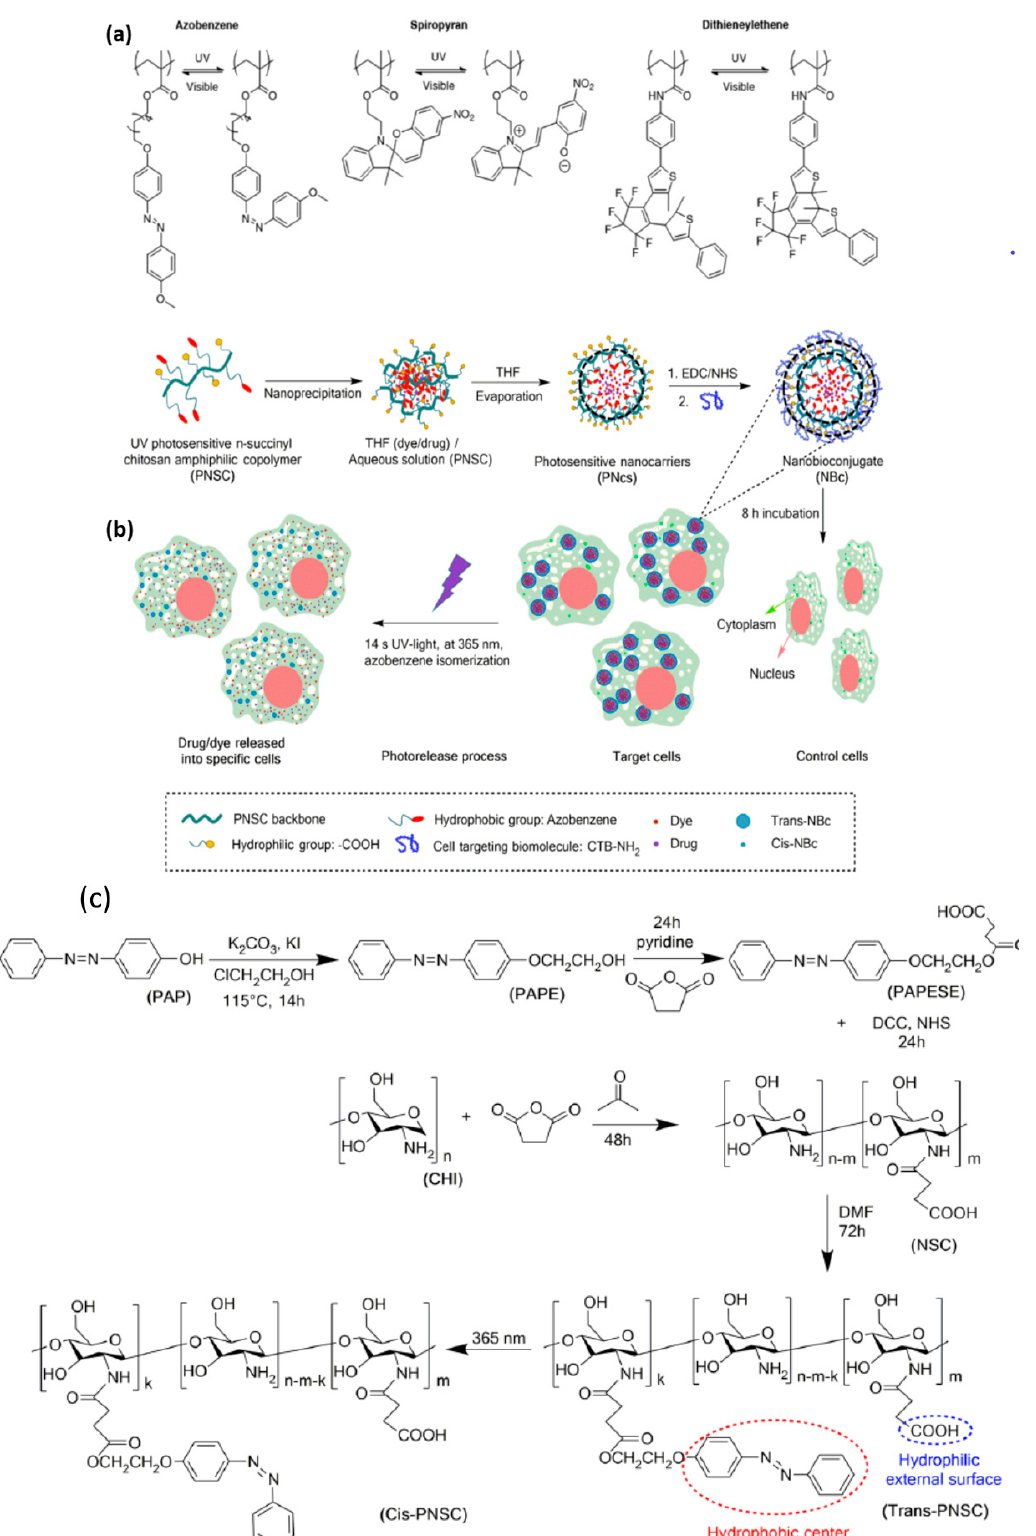
Figure 4. ( a ) Examples of photoisomerizable groups for reversible light ‐ responsive nanomaterials. Reproduced from [65], with permission from © The Royal Society of Chemistry 2017. ( b ) Synthesis of PNc and UV light drug release. ( c ) Synthesis and photoisomerization process of PNSC amphiphilic copolymer. Reproduced from [70], with permission from © 2020 Mena ‐ Giraldo, Perez ‐ Buitrago, Londono ‐ Berrío, Ortiz ‐ Trujillo, Hoyos ‐ Palacio, and Orozco under CC BY 4.0.